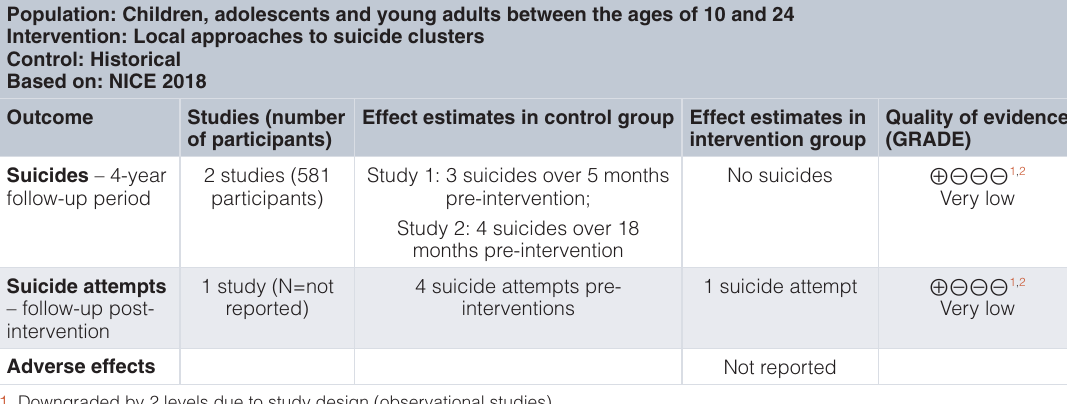
Table 4. GRADE-assessment: Primary prevention: local approaches following suicide clusters versus historical control. Population: Children, adolescents and young adults between the ages of 10 and 24 Intervention: Local approaches to suicide